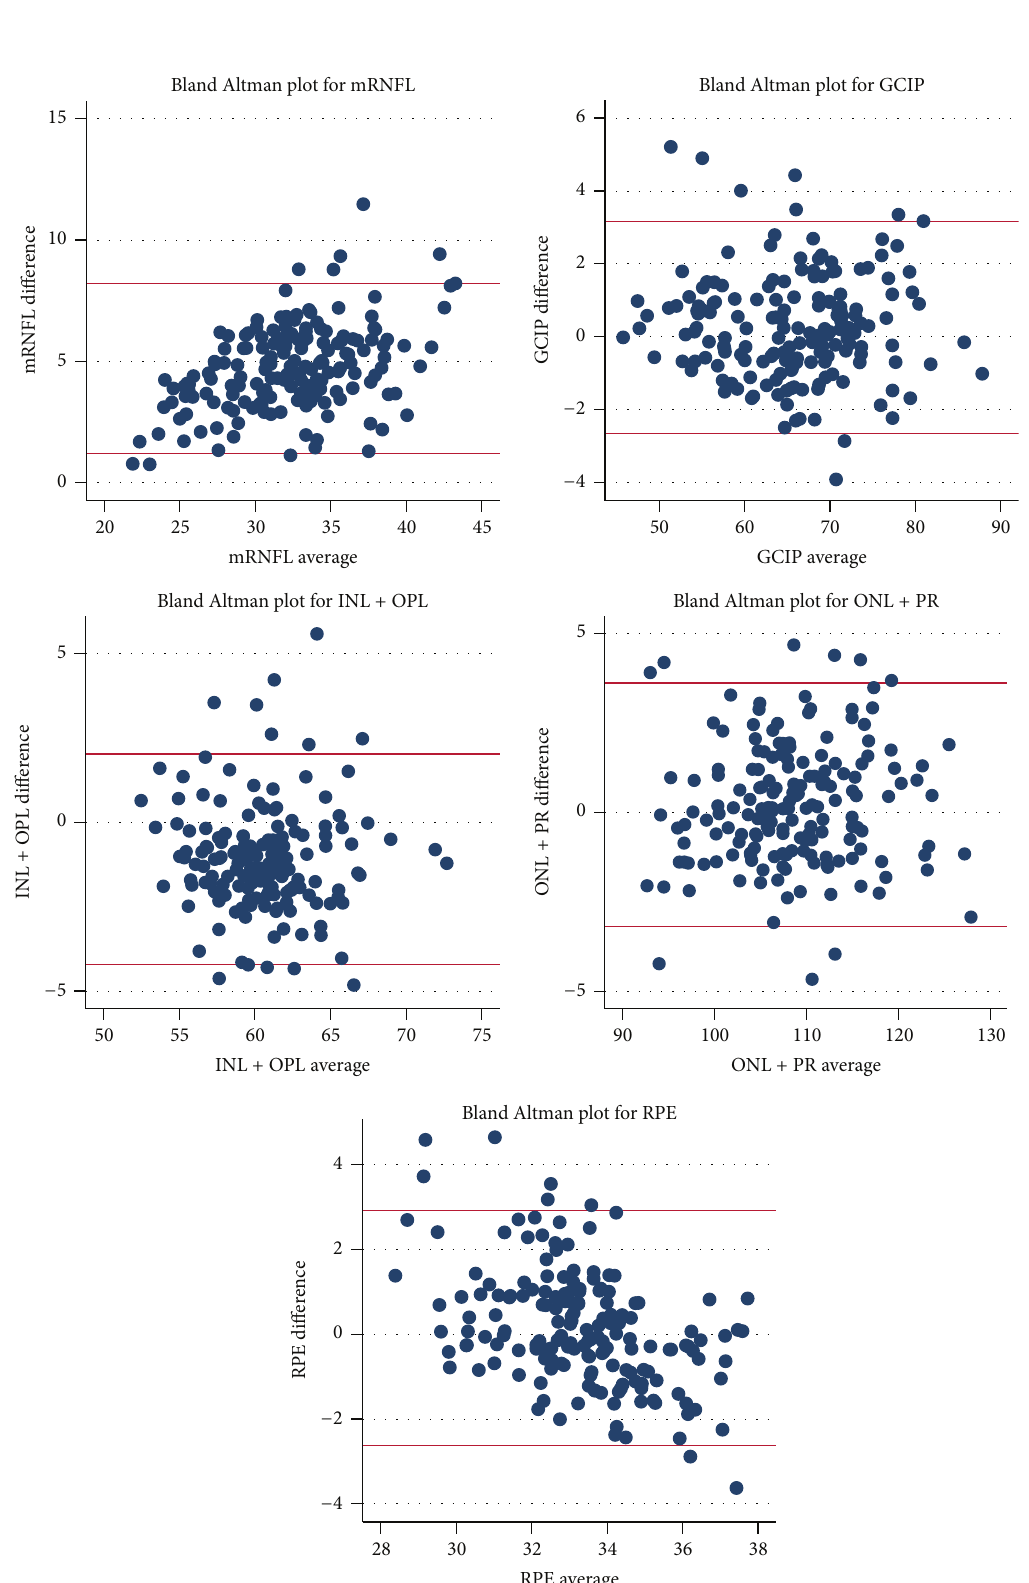
Figure 2: Bland-Altman plots of cross-sectional comparison of retinal layer segmentation. Scatter plots of the difference in measurement between the two scanners versus average of measurement from two scanners. The horizontal lines represent the upper and lower limits of agreement (LOA). The majority of plotted points fall within the LOA as expected in all